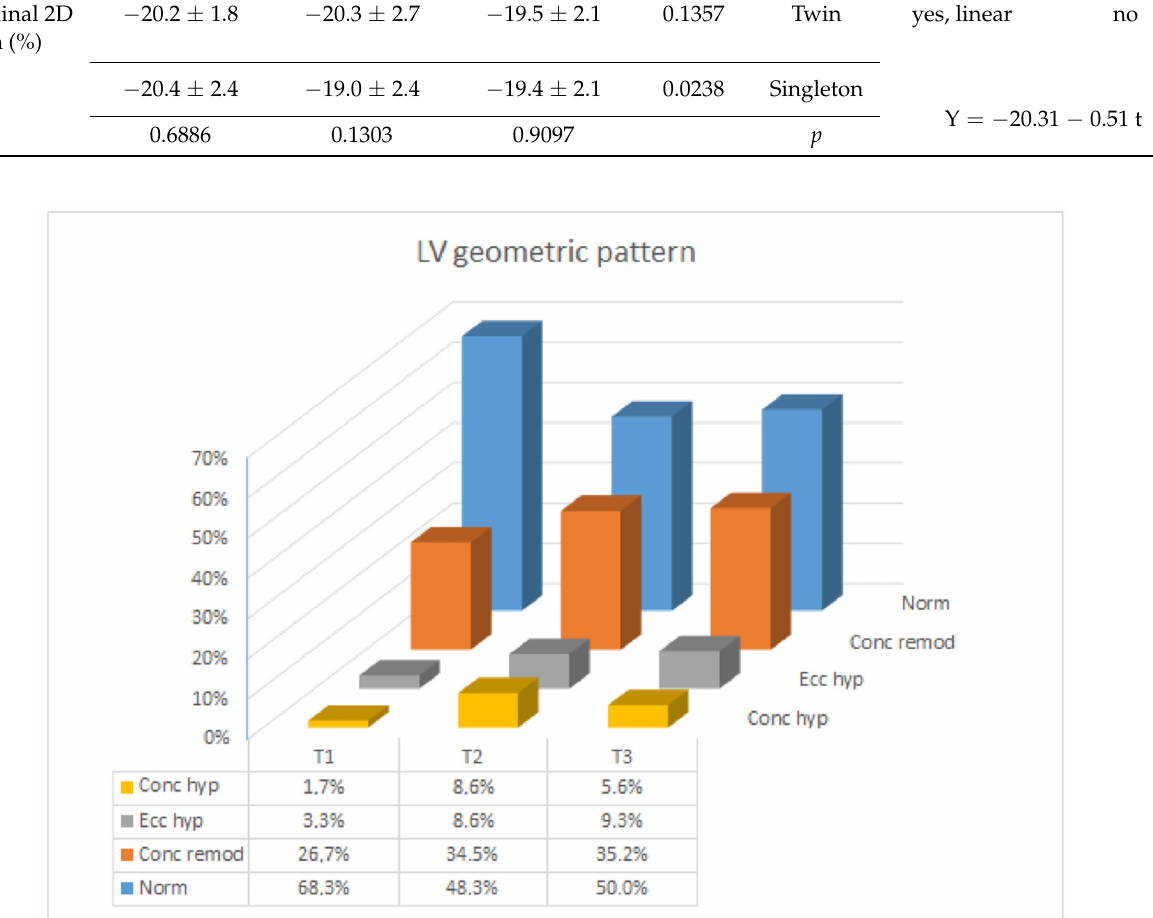
Figure 1. Left ventricular geometric pattern in the whole